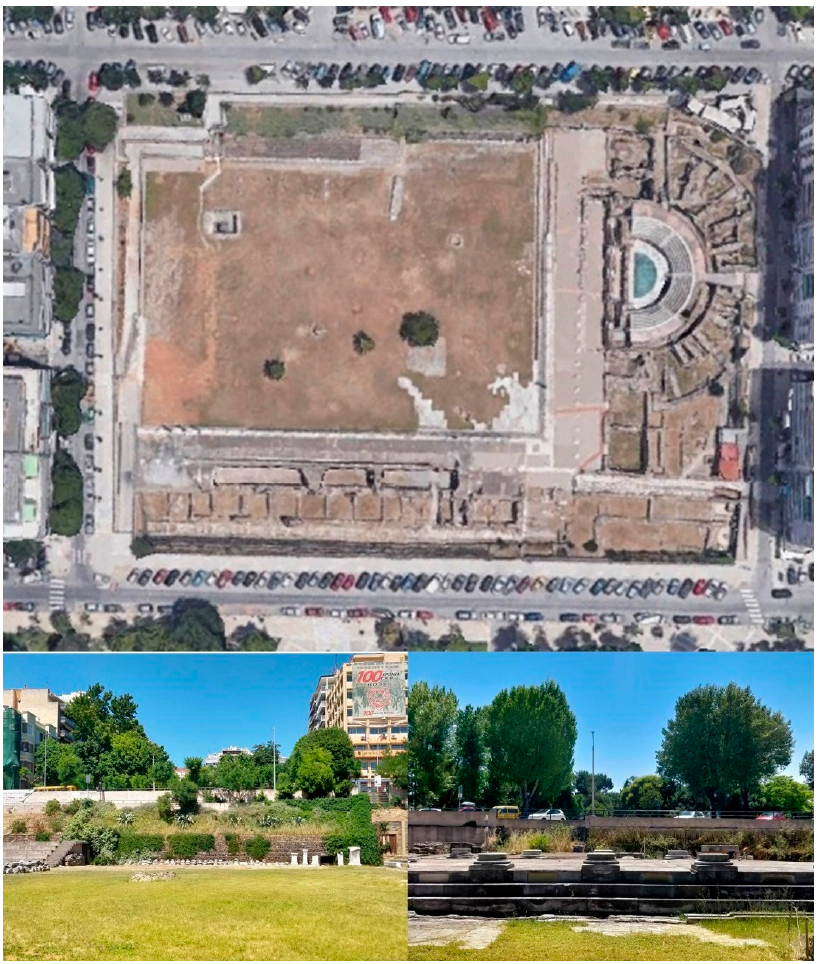
Figure 2. The Ancient Roman Agora presented in the map. The pictures of the area were taken by the authors at the same time as the sampling protocol was followed. Table 1. The Roman Agora soundscape characteristics as highlighted by the researchers. Roman